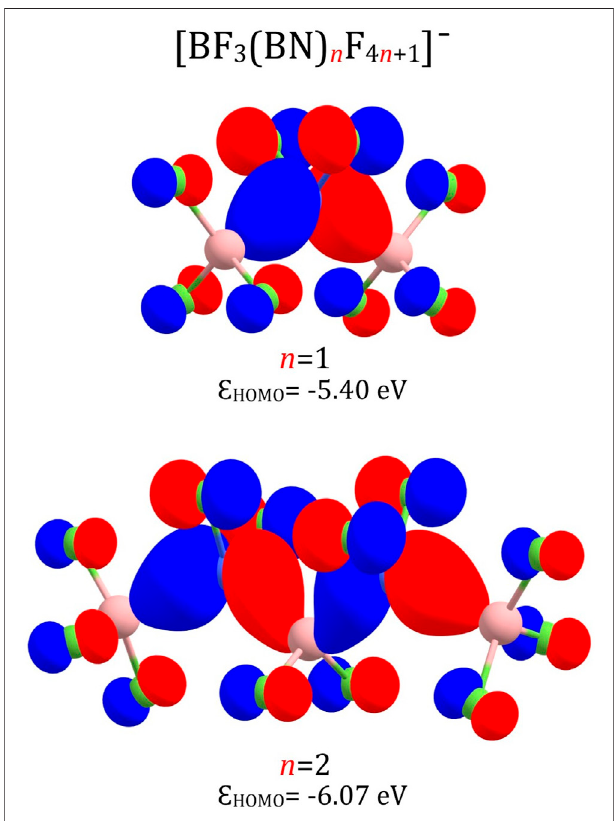
FIGURE6| HOMOorbitalsofthe(BF 3 (BN)F 5 ) – and(BF 3 (BN) 2 F 9 ) – anions with their orbital energies ( ε ).